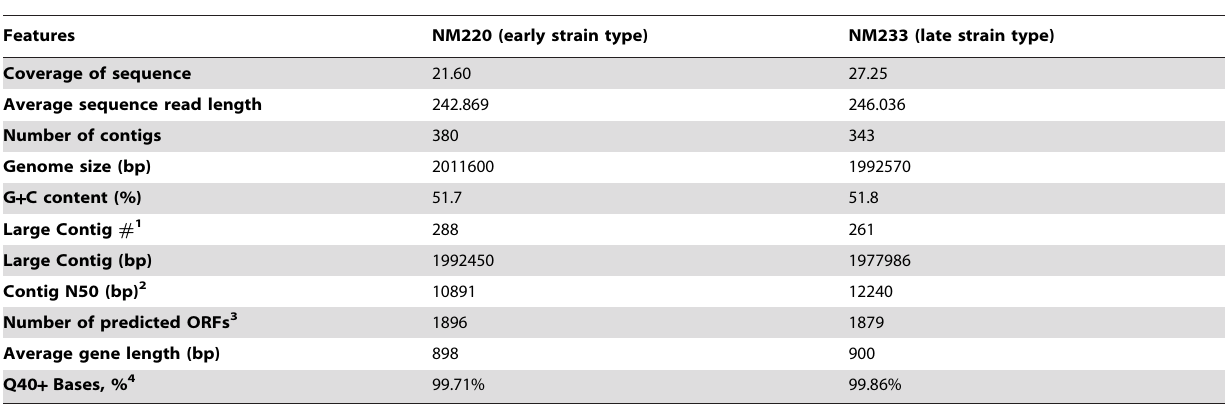
Table 1. General Features of Sequenced Genomes.